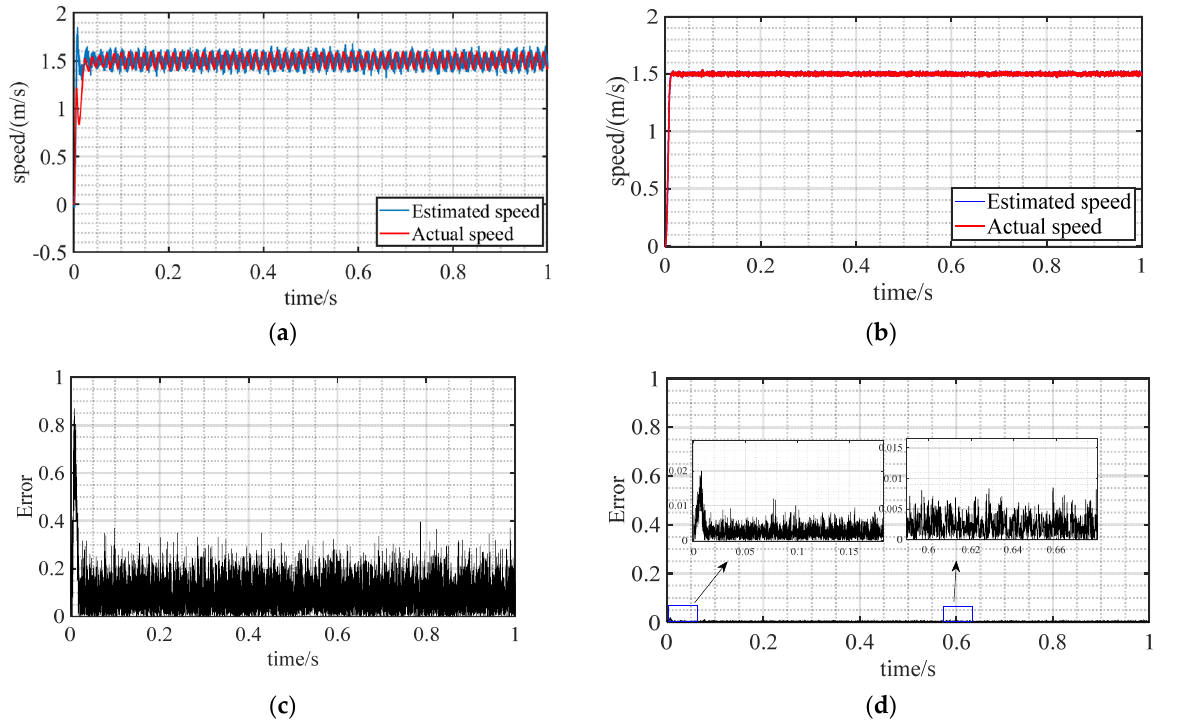
Figure 12. Comparison of the operation of the two observers; ( a ) comparison between the observation speed and the actual speed of conventional SMO; ( b ) comparison between the observation speed and the actual speed of F-ST-SMO; ( c ) observation error of conventional SMO; ( d ) observation error of F-ST-SMO.